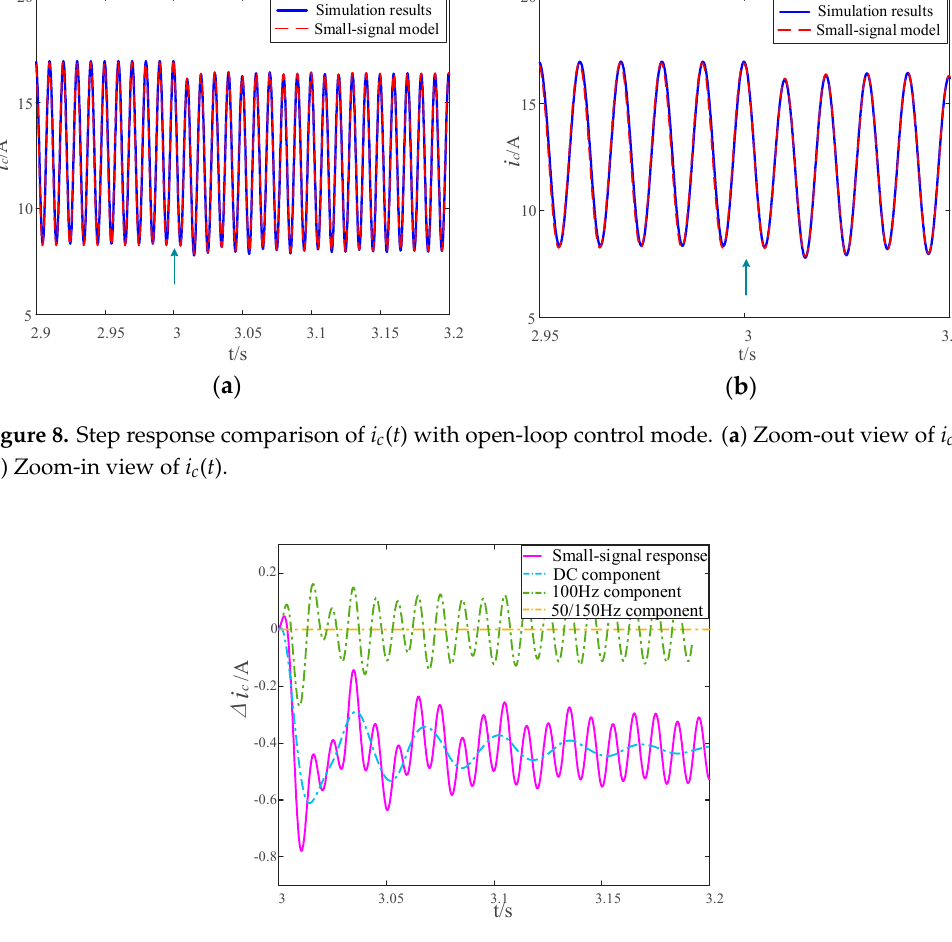
Figure 9. Harmonic components of Δ i c ( t ) with open loop control mode.